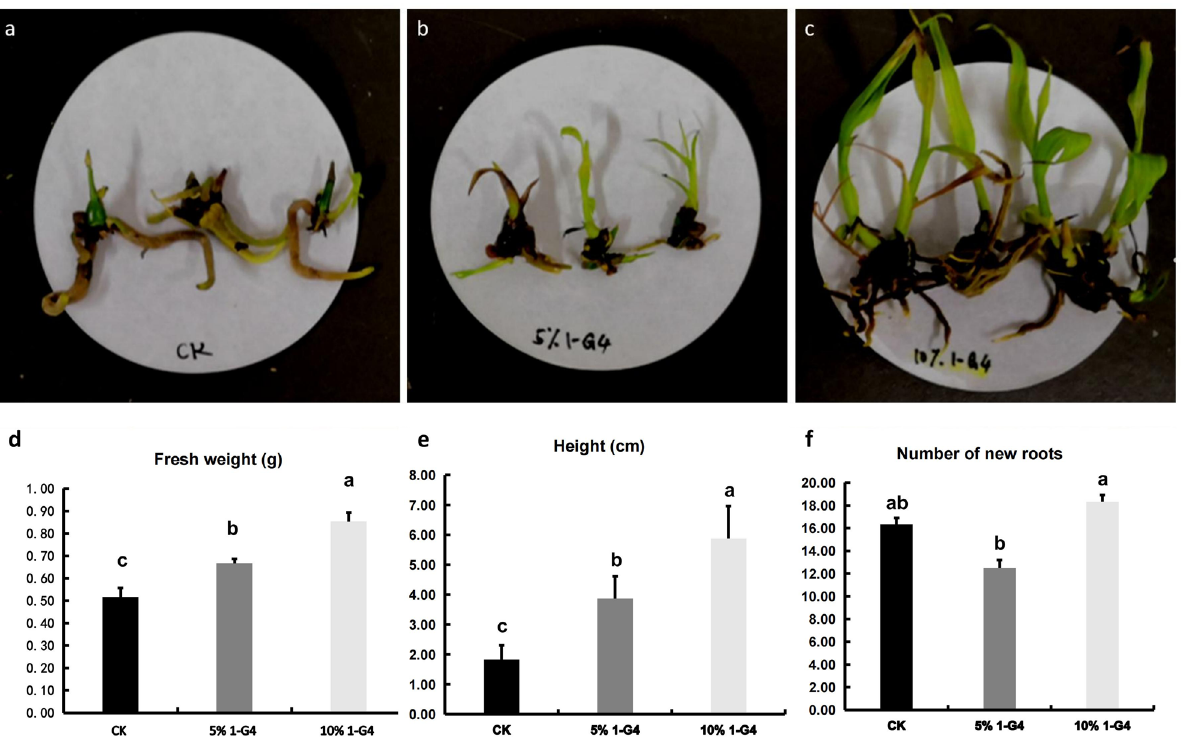
Figure 1. The growth and development of B. striata under different concentrations of 1-G4 elicitor. ( a – c ) Phenotypic changes of control, 5% 1-G4, and 10% 1-G4 treated BS. ( d ) Fresh weight of control, 5% 1-G4, and 10% 1-G4 treated BS. ( e ) Height of control, 5% 1-G4, and 10% 1-G4 treated BS. ( f ) New roots number of control, 5% 1-G4, and 10% 1-G4 treated